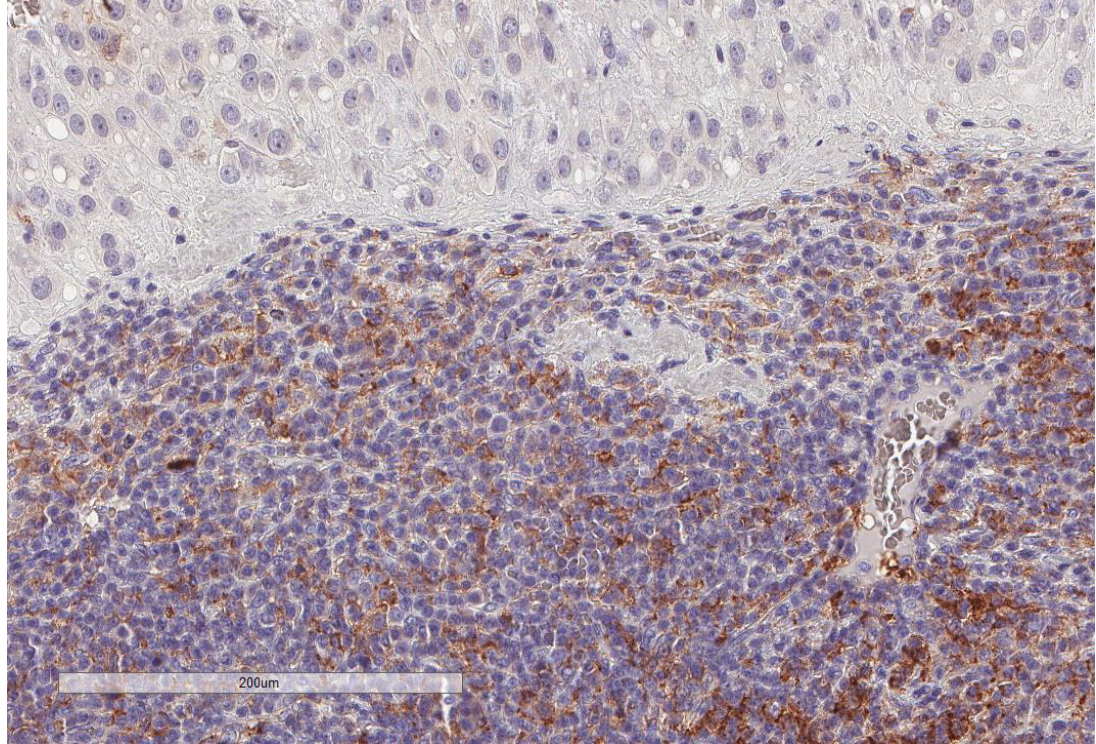
Figure 7. Representative microscopic image (×200 magnification) of PD-L1 expression but not tumor cells. The upper part of the image shows the tumor, and the lower part shows the inflammatory cells.